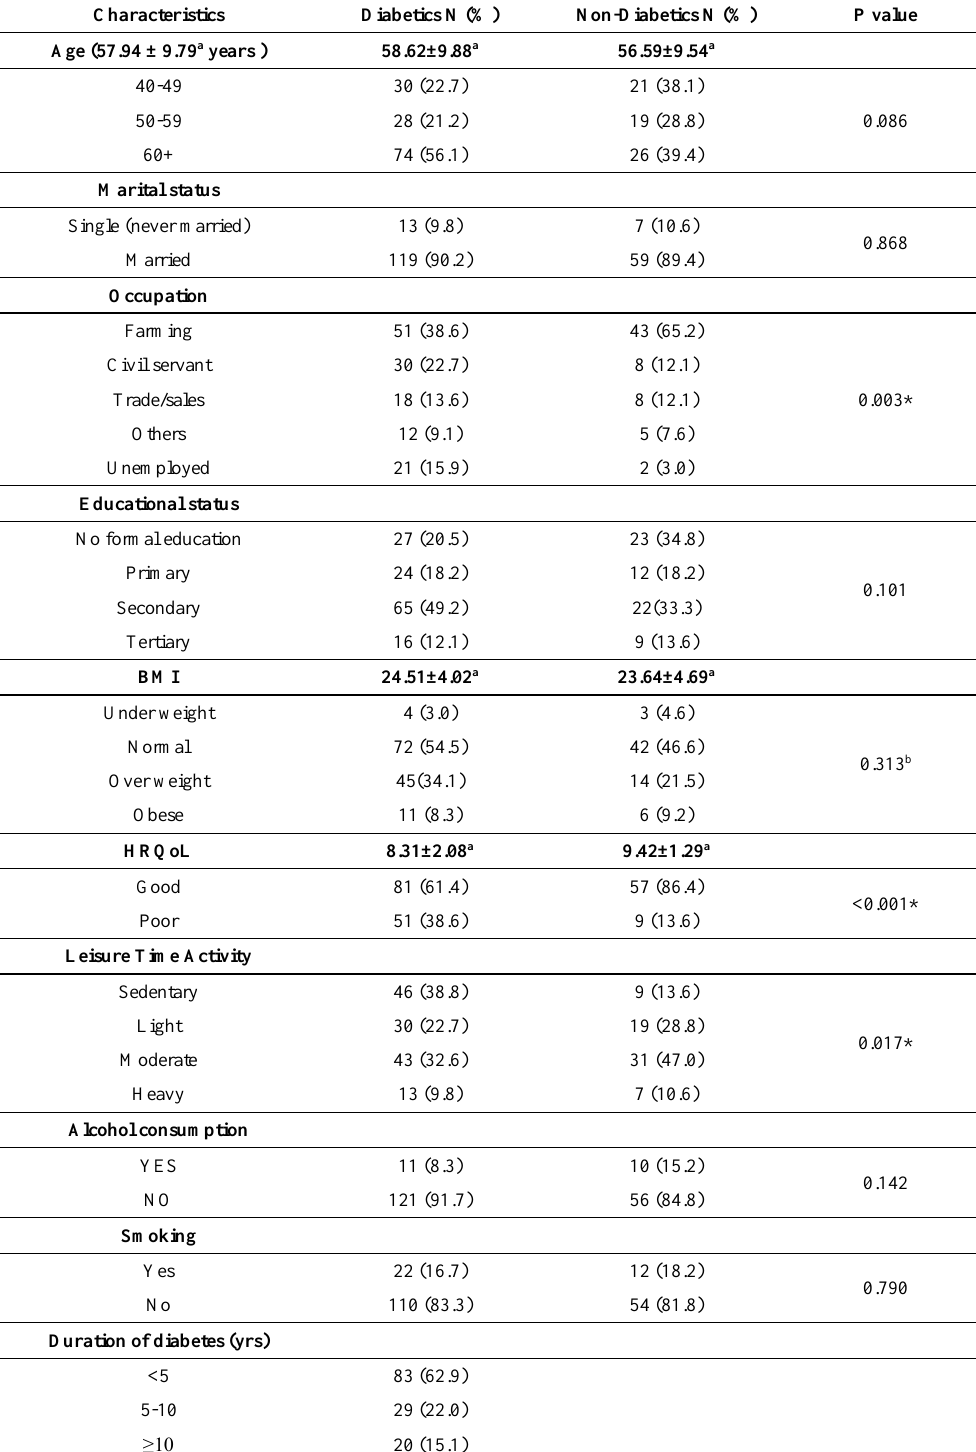
Table 1. General and lifestyle characteristics of study subjects (N=198)